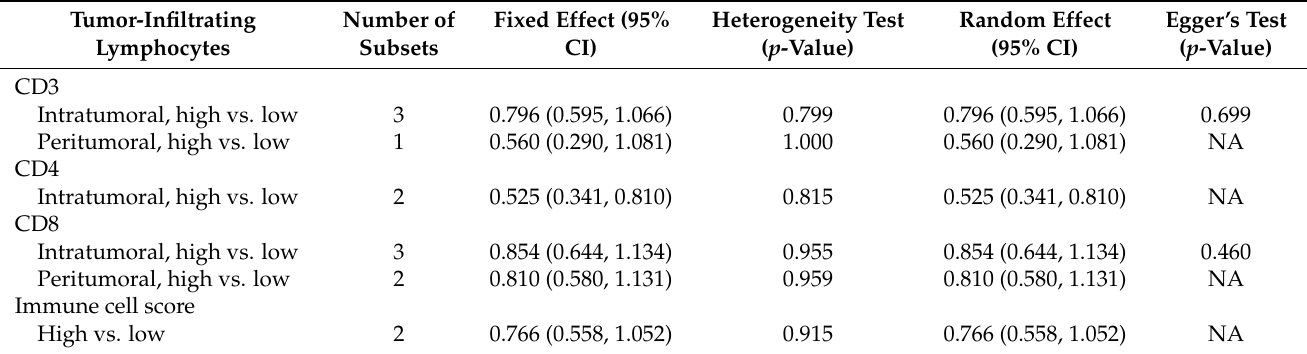
Table 4. Correlation between intra- and peritumoral infiltrating lymphocytes and disease-free survival in pancreatic ductal